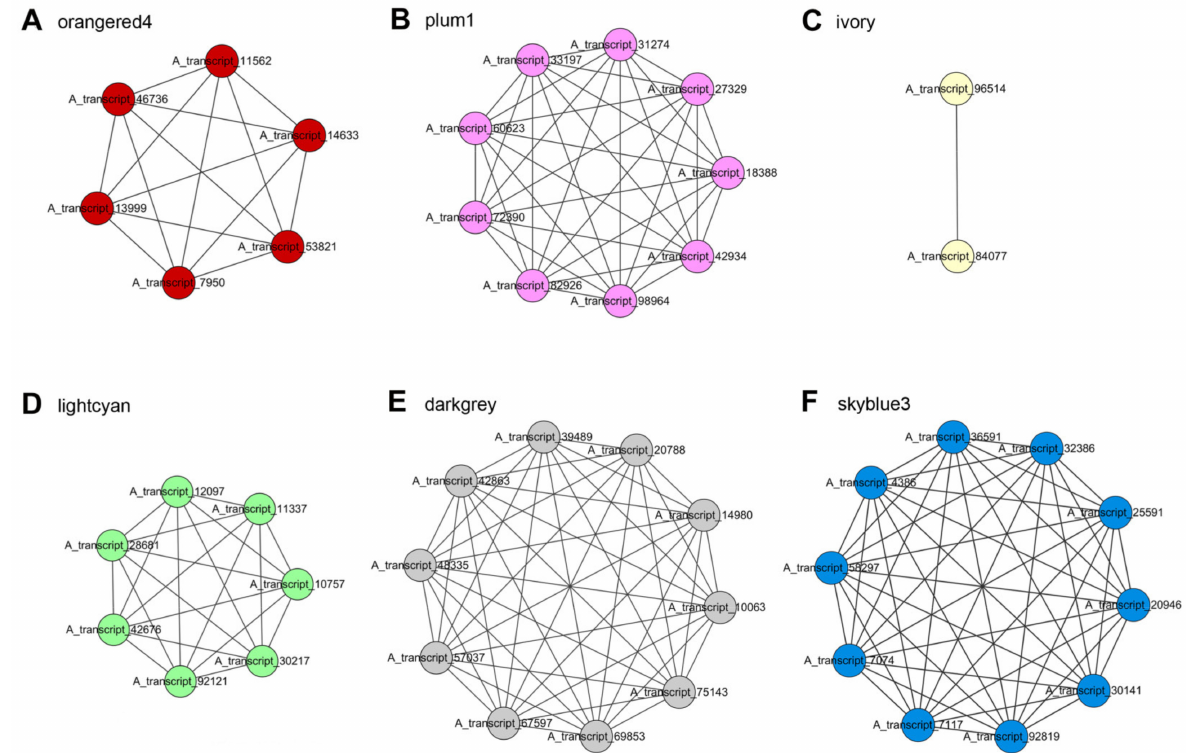
Figure 7. Co-expression networks of orangered4 ( A ), plum1 ( B ), ivory ( C ), lightcyan ( D ), darkgrey ( E ), and skyblue3 ( F ) constructed using carvacrol-related and peltate glandular trichome-related module genes in Origanum vulgare ‘Hot and